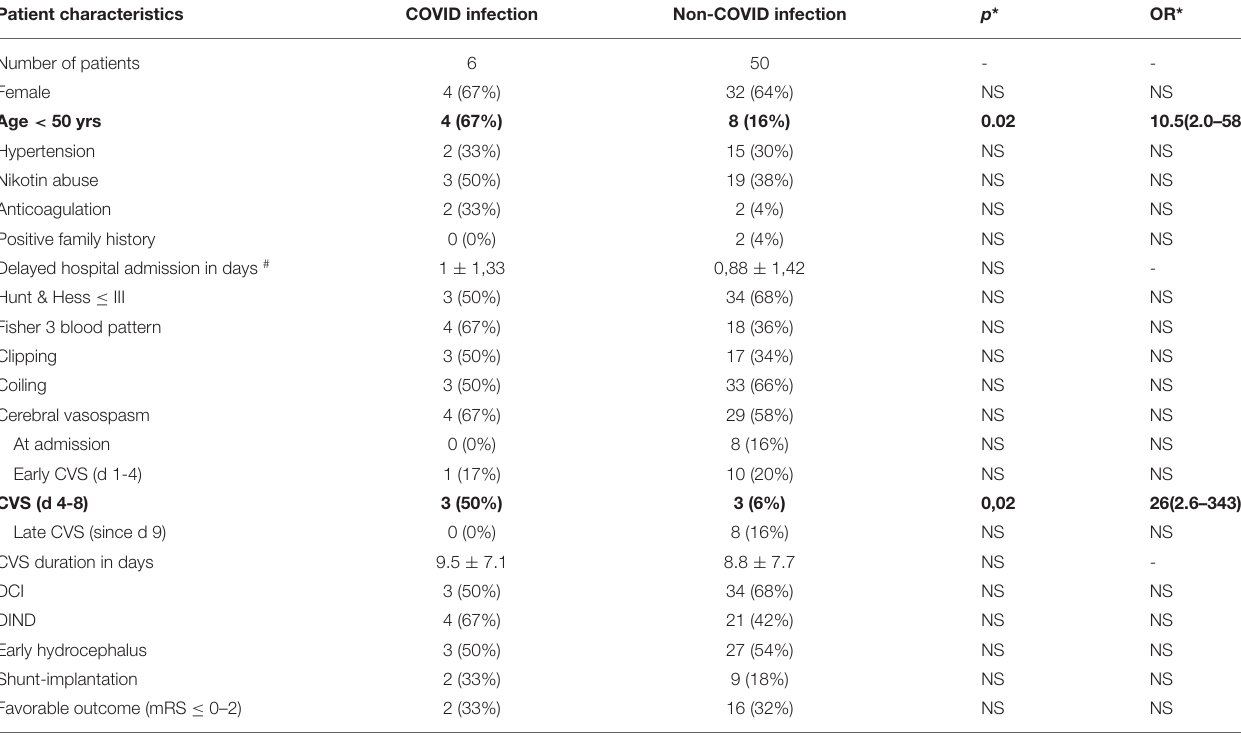
TABLE 3 | Characteristics of patients with aSAH during 1 year of COVID-19 pandemic (03/20-02/21) w/o previous COVID Infection. Patient characteristics